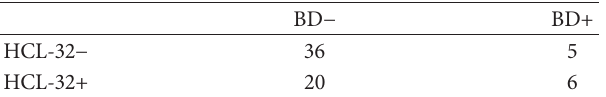
Table 2: HCL-32 positive patients (standard cut-off ∗ ) and diagnosis of BD. BD −